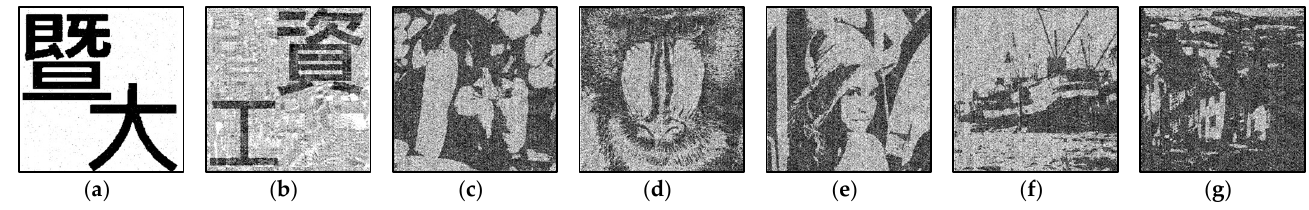
Figure 10. Experimental results by Method 3 for (5, 5) with p = 45, γ = 0.5. ( a , b ) Restored images R 0 , R 1 ( c )–( g ) Shares M 0 , …, M 4 .